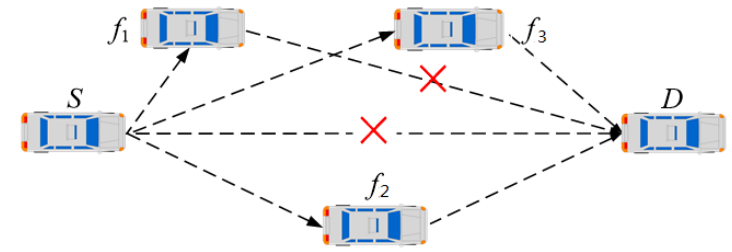
Figure 1. Vehicular ad hoc network (VANET) scenario on the